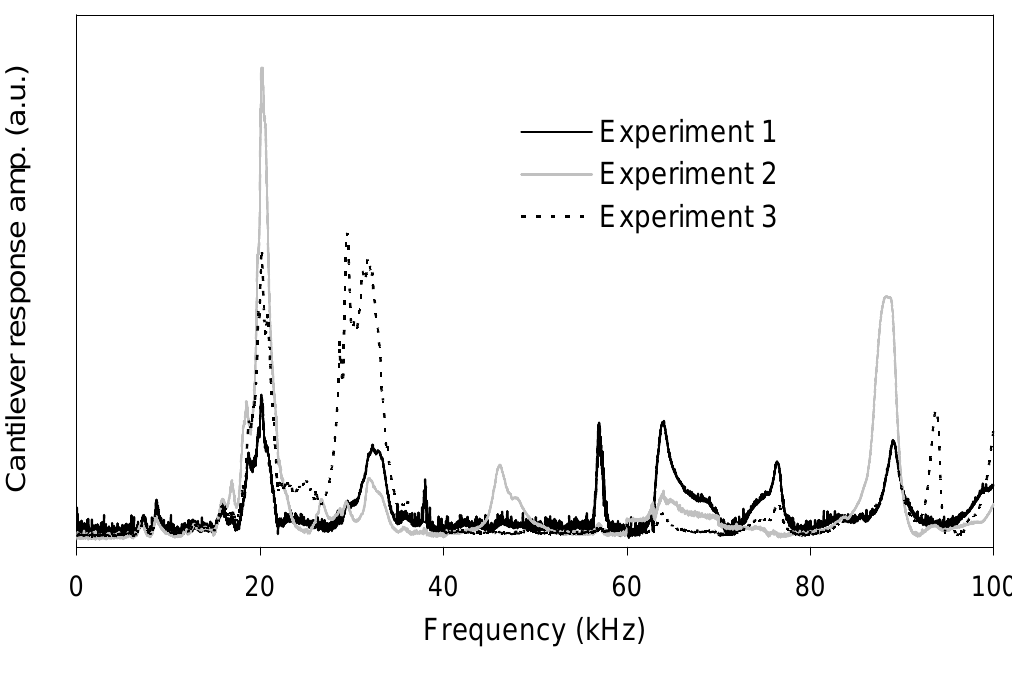
Figure 3. Frequency responses of cantilever 1 with different cantilever base and clip positions (in water). The fundamental resonant frequency of this cantilever is approximately 20